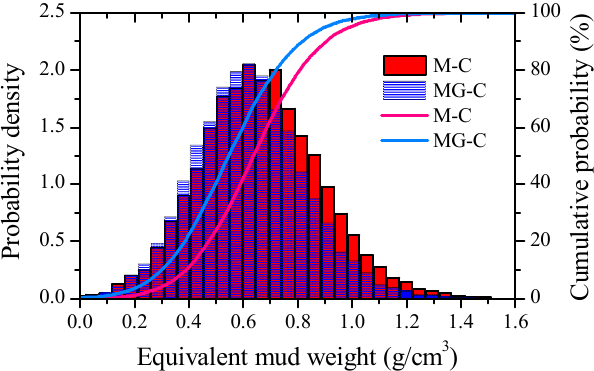
Figure 6. Probability density histogram of basic parameters.